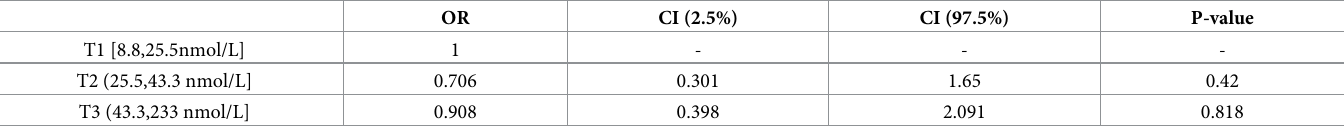
Table 5. Results of multivariate analysis to estimate the risk (odds ratio) of developing a HAI according to vitamin D concentration, expressed in tertiles and adjusted for sex, age, transfusions, vasopressors, surgery duration, and length of stay. OR CI (2.5%) CI (97.5%) P-value T1 [8.8,25.5nmol/L] 1 - - - T2 (25.5,43.3 nmol/L] 0.706 0.301 1.65 0.42 T3 (43.3,233 nmol/L] 0.908